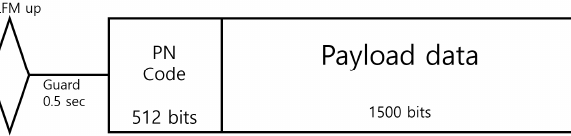
Figure 5. Packet structure for simulation.